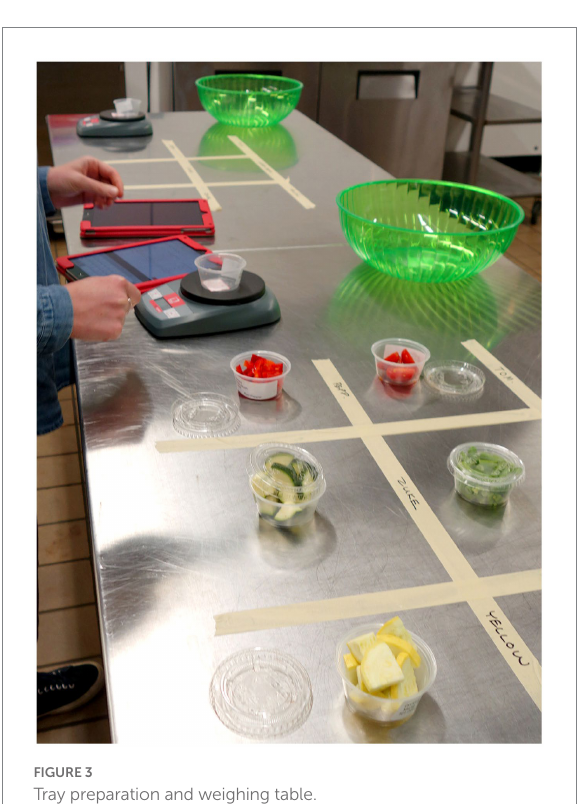
FIGURE 3 Tray preparation and weighing